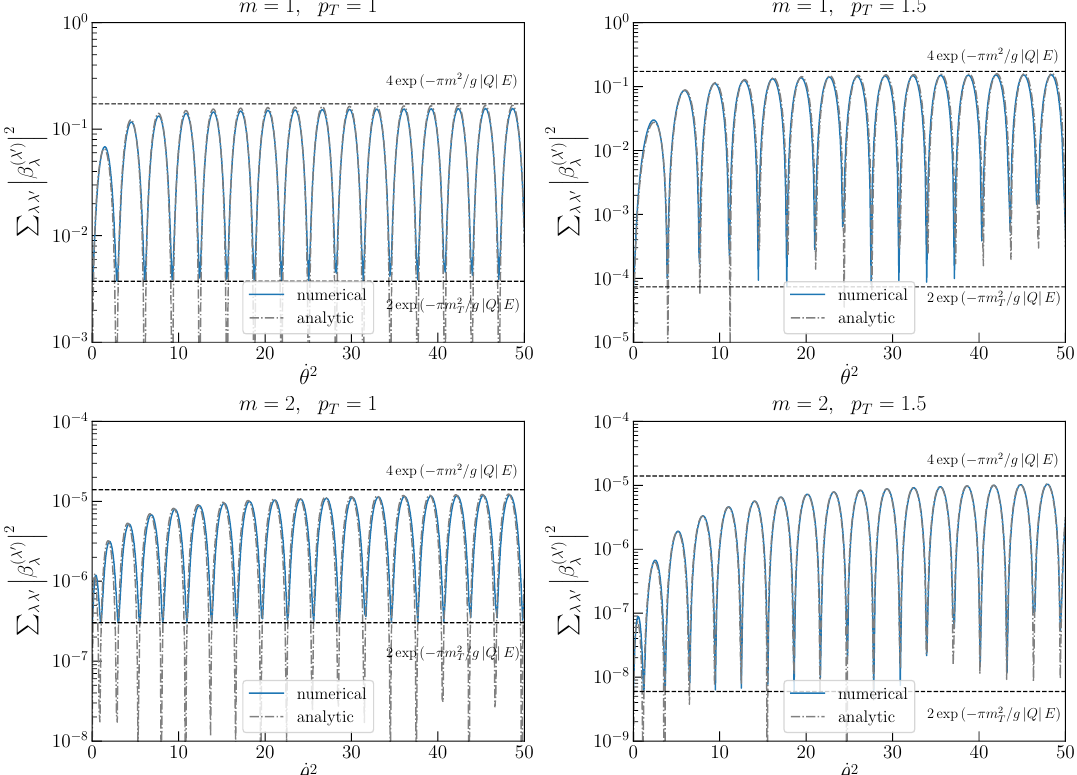
0 ) | β ( λ | 2 evaluated at p z = − 50 as a λλ 0 λ is small T